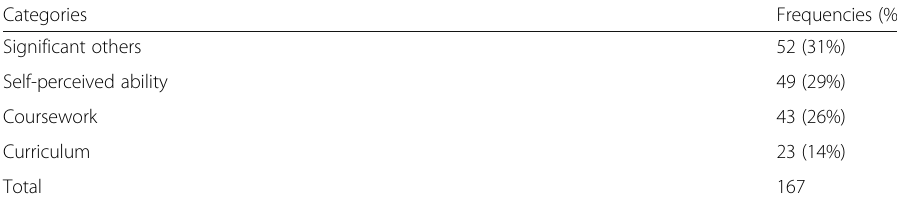
Table 2 Major categories in the diary